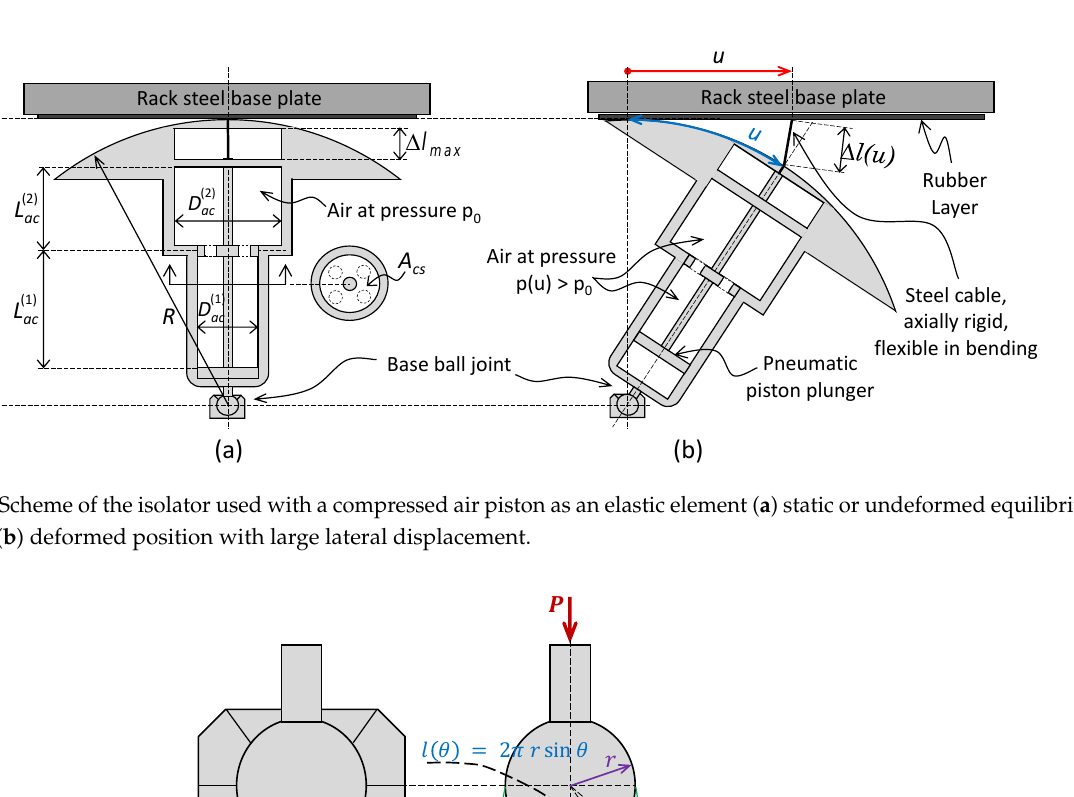
Figure 2. Scheme of the isolator used with a compressed air piston as an elastic element ( a ) static or undeformed equilibrium position, ( b ) deformed position with large lateral displacement.